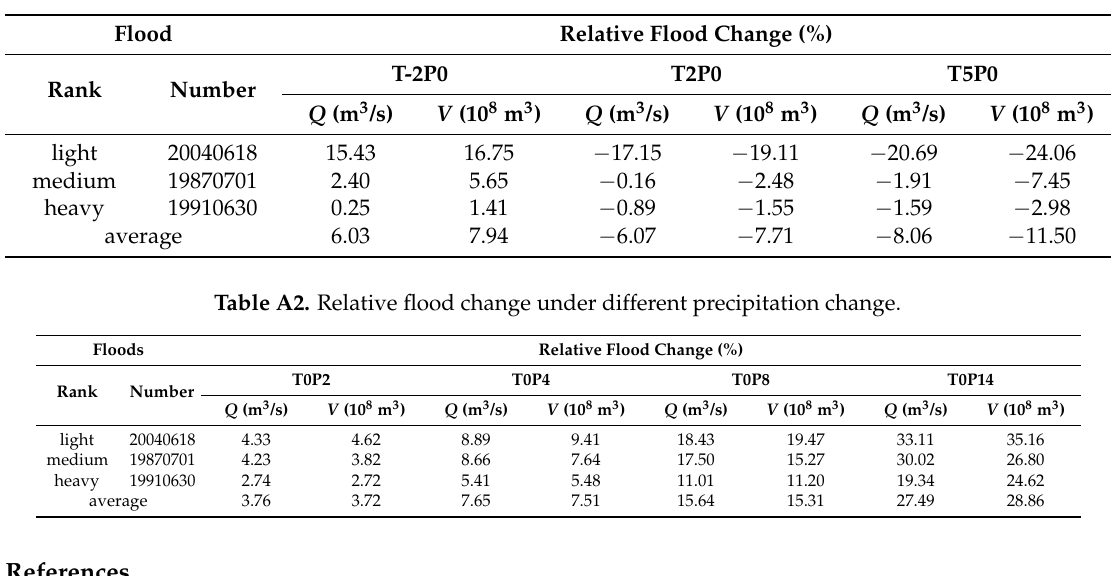
Table A1. Relative flood change under different temperature change.